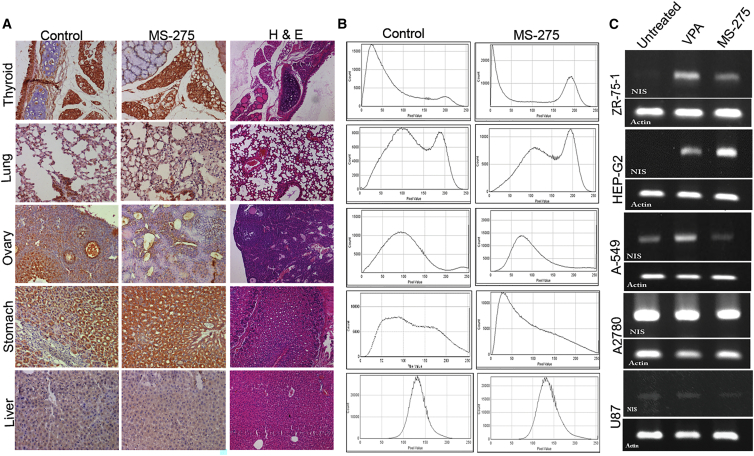
bHDACi Differentially Regulates NIS Expression across Organs In Vivo(A) Photomicrographs of NIS IHC performed on mouse thyroid, lung, ovary, stomach, and liver tissues harvested from untreated control or MS-275-treated mouse. DAB staining (brown) and respective H&E-stained images are displayed. (B) Histogram profiles of DAB-stained tissue sections showing NIS intensity profile obtained by using IHC Profiler program. (C) Images of gel picture showing amplified NIS transcripts as a measure of response to VPA and MS-275 drug treatment in various cancer cell lines, i.e., BC (ZR-75-1), lung cancer (A-549), hepatocellular carcinoma (HEPG2), ovarian cancer (A2780), and glioblastoma (U87). β-actin housekeeping gene is used as loading control.